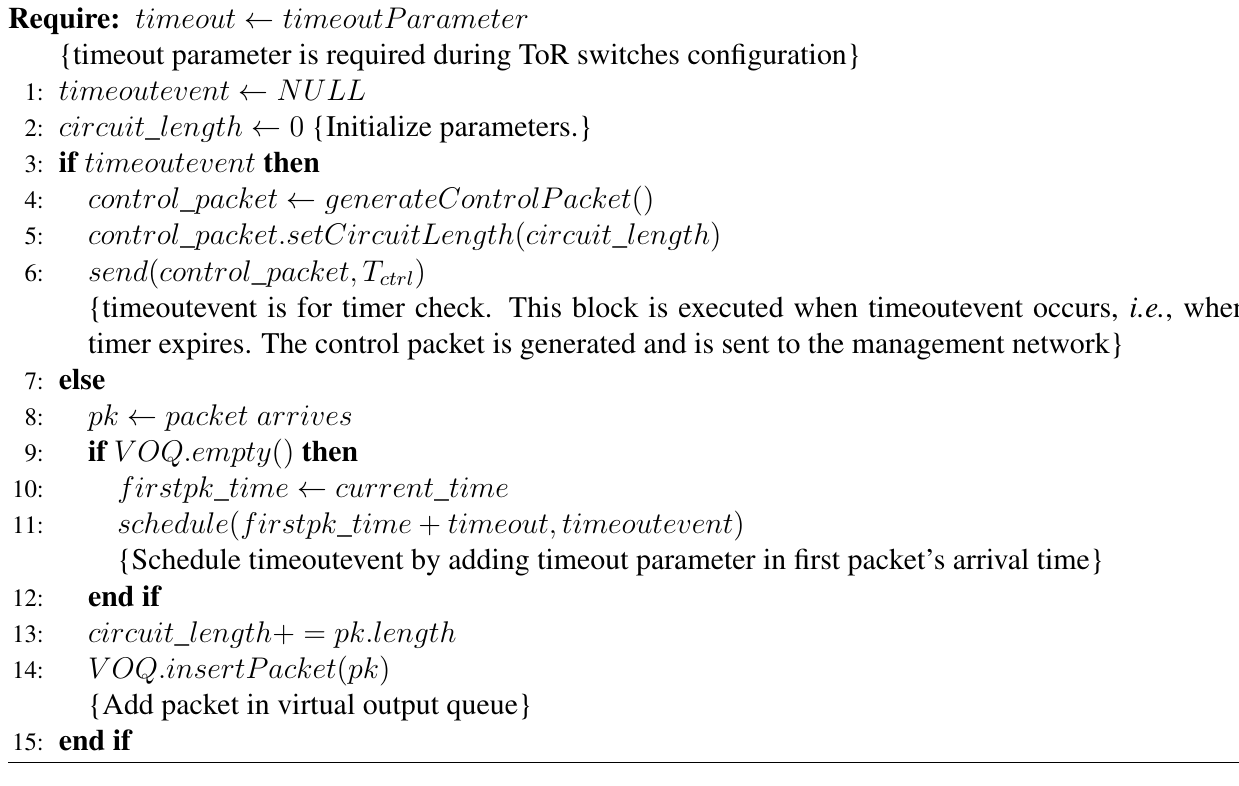
Algorithm 1 Traffic Aggregation Mechanism at ToR